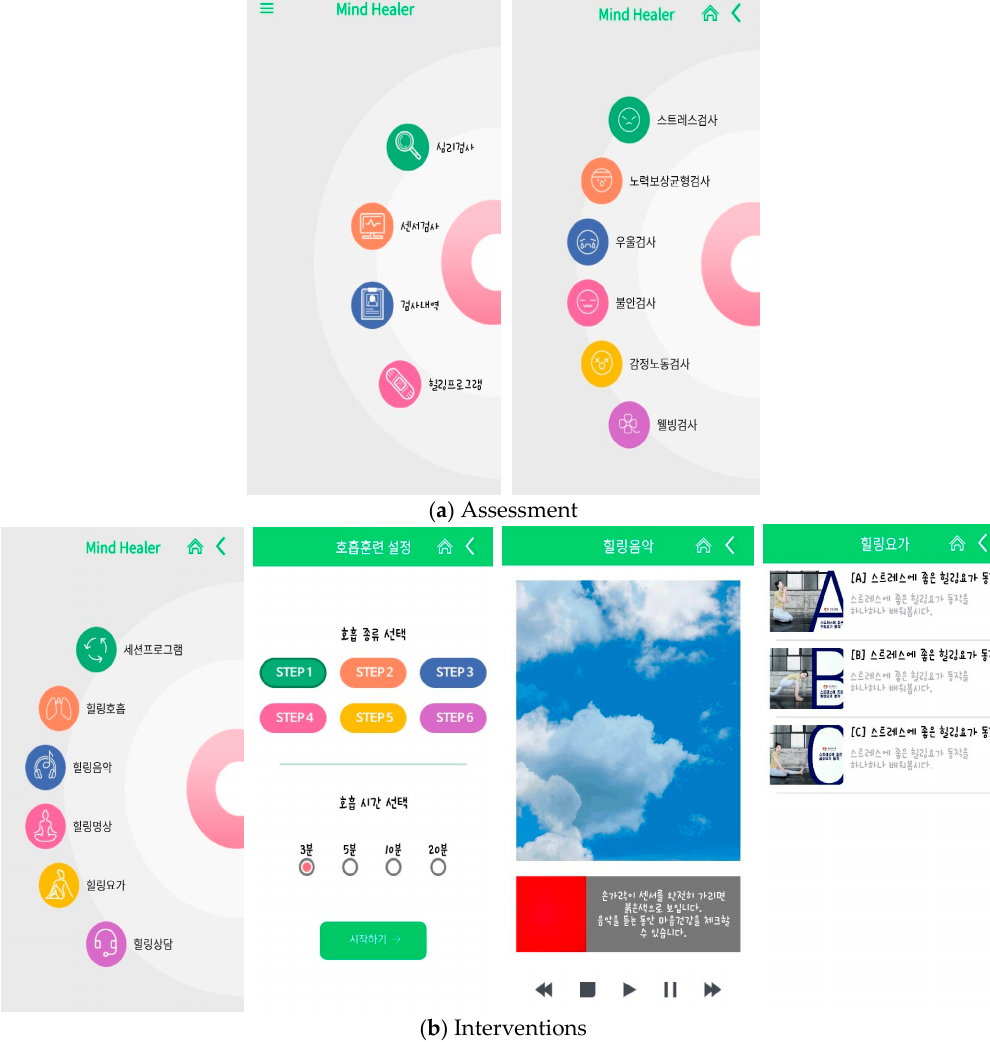
Figure 2. App configuration: ( a ) describe the content of the assessment; ( b ) describe the content of the interventions.